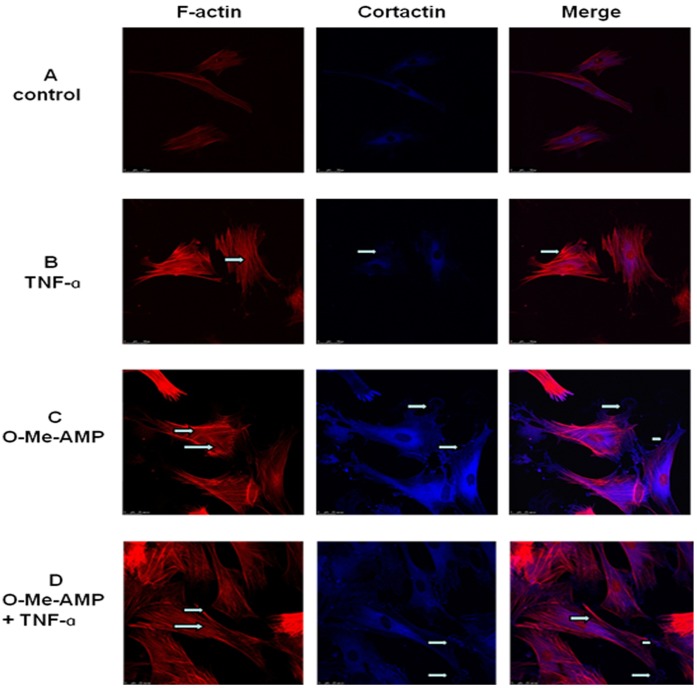
Effect of increased Rac1 activity on the rearrangement of F-actin and the distribution of cortactin. Cells were treated with TNF-α (B) for 2 hours or with O-Me-cAMP (C) for 1 hour or co-treated with O-Me-cAMP and TNF-α (D). In untreated cells, few stress fibers were seen, cortactin was detected both in the cytoplasm and along with some parts of the cell membrane (A). Exposure to TNF-α (B) induced stress fiber formation and the disappearance of cortactin from the cell periphery (shown by arrows); O-Me-cAMP (C) led to a loss of stress fibers and strengthened the peripheral actin band, moreover, caused an increase in the formation of lamellipodia and a change in cortactin localization to cell periphery forming a continuous linear staining pattern (C) (shown by arrows). Co-treatment with O-Me-cAMP prevented the TNF-α response (D) remarkably. Moreover, O-Me-cAMP induced lamellipodia increasing, dramatically attenuated the disappearance of cortactin from the cell periphery, and resulted in partial disappearance of central stress fibers (shown by arrows). All the images shown are representative of four independent experiments.